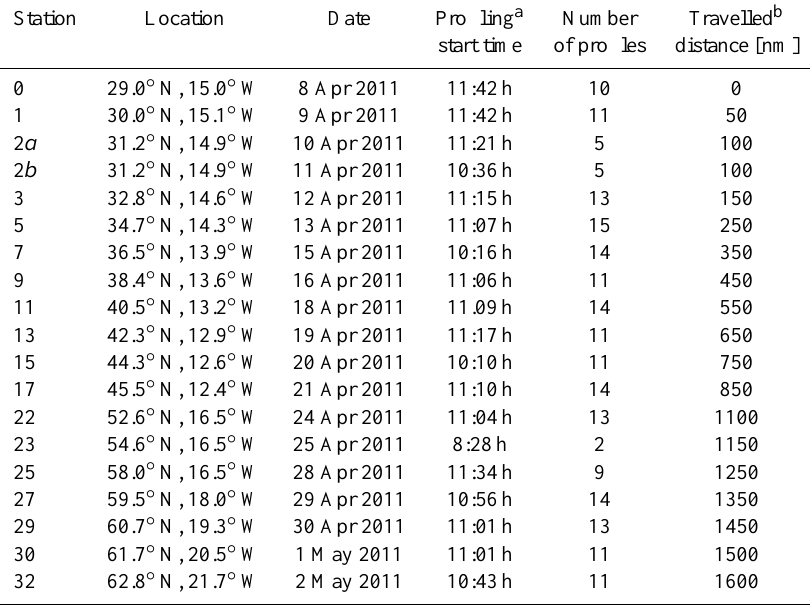
Table 1. Information of the CTD stations where SCAMP measurements were performed during the STRATIPHYT-II cruise. Station Location Date Profiling a Number Travelled b start time of profiles distance